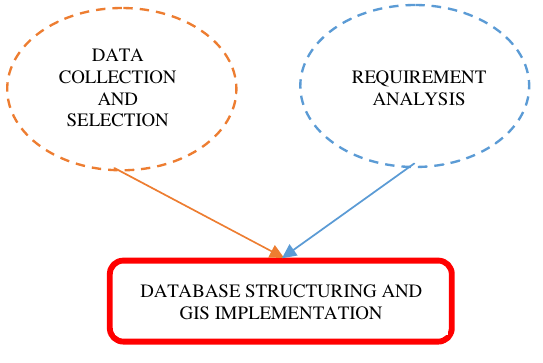
Figure 2. The three steps of the CIPA project